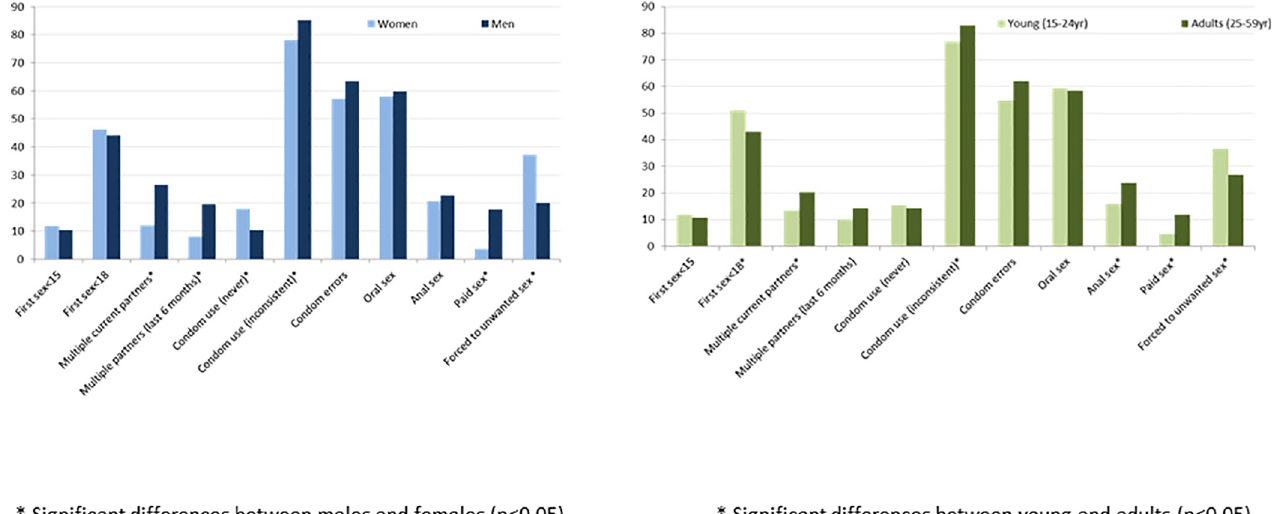
Fig 1. Sexual behaviors among the sexually active OKAPI cohort participants (N =